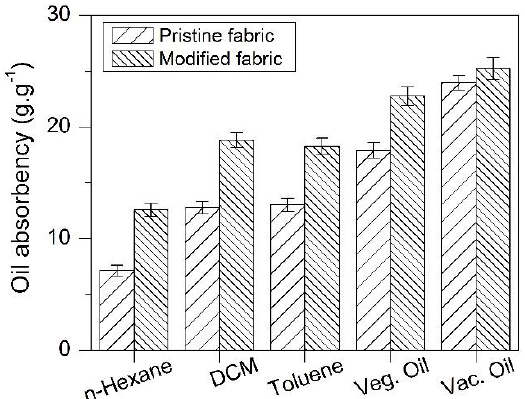
Figure 10. Sorption capacities of pristine and modified cotton fabric for different oils.